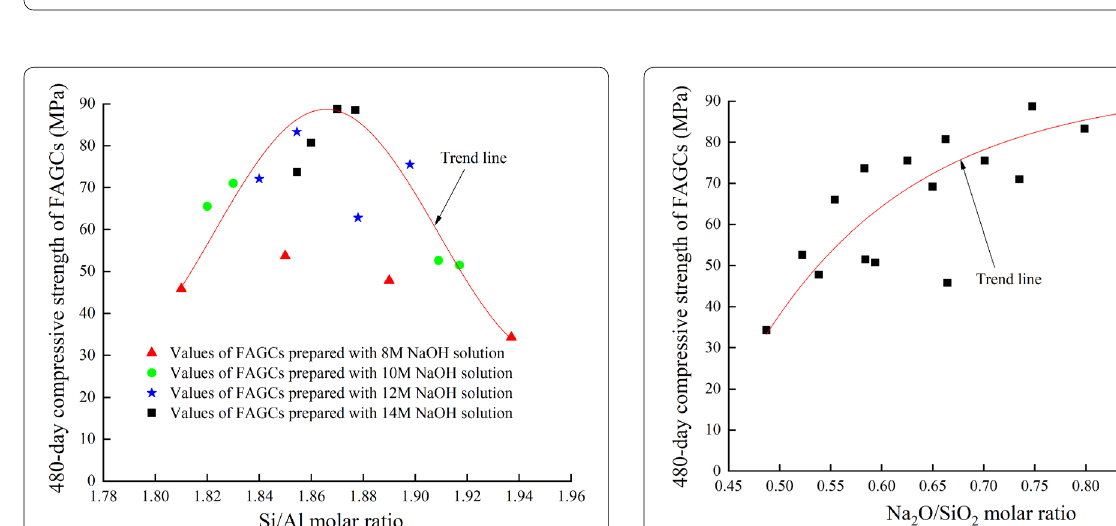
Fig. 5 The relationship between 480-day compressive strength of FAGC and Na 2 O/SiO 2